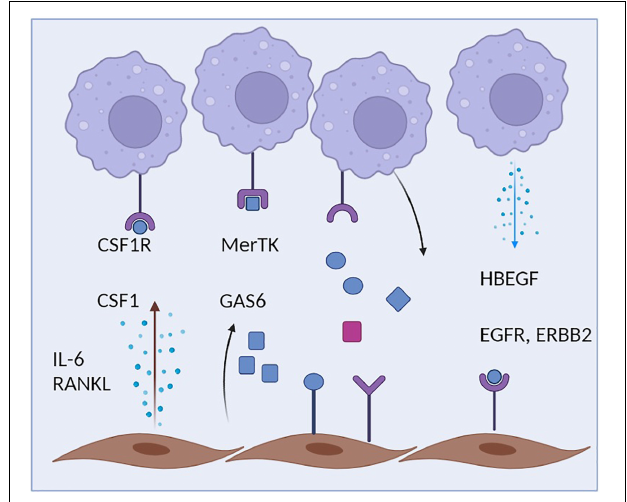
FIGURE 2 | Crosstalk of macrophages and fibroblasts. Synovial macrophages are capable of sensing multiple fibroblast-derived factors including Csf1 and Gas6. During inflammation, Synovial fibroblasts additionally secrete IL-6, which amplifies the inflammatory response of both macrophages and fibroblasts. Synovial fibroblasts, in turn, rely on macrophage-derived HBEGF.